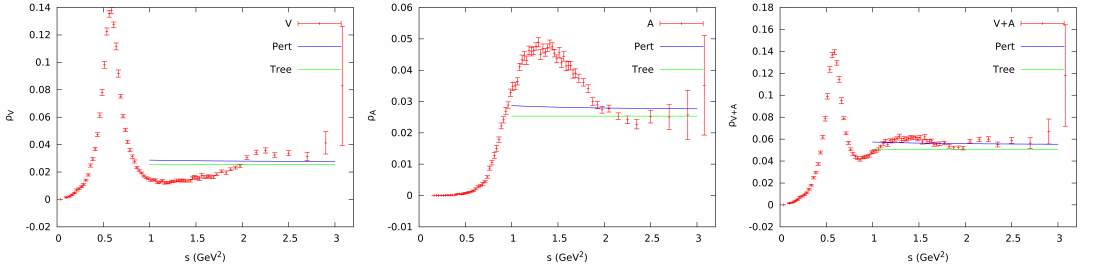
Figure 1: ALEPH spectral functions for the V , A and V + A channels [ 8 ]